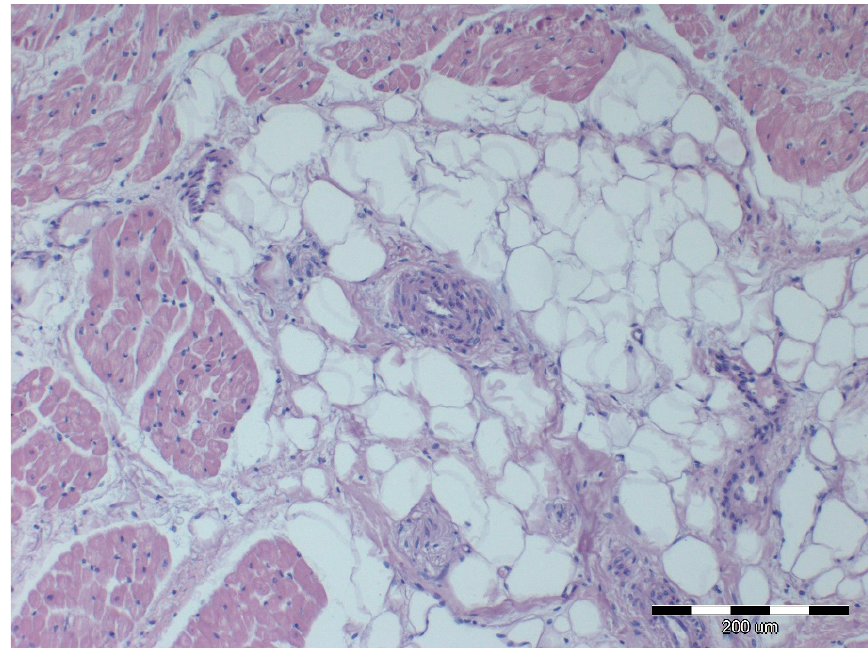
Figure 8. Microscopic image of the heart muscle specimen with coronary artery from an extremely obese horse. The wall of the right ventricle: in the center, a coronary vessel with a thickened wall; moderate degeneration of muscle cells; intense perivascular steatosis; HE staining; 100×.